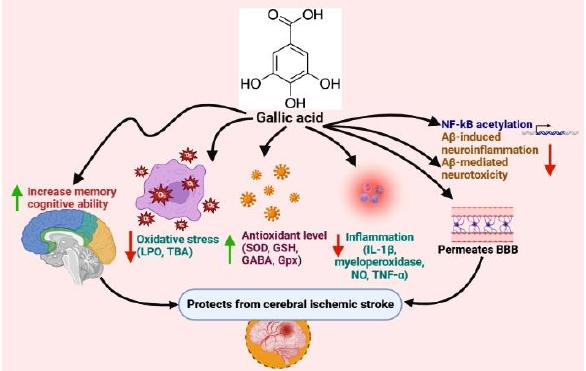
Figure 1. Effects of gallic acid on ischemic stroke (image created using biorender.com (accessed on 21 October 2022)). 21 October